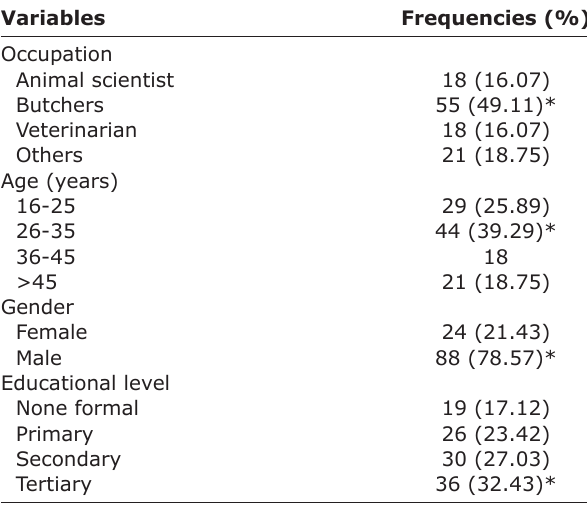
Table-1: Demography of the respondents in Gombe township abattoir, Nigeria. Variables